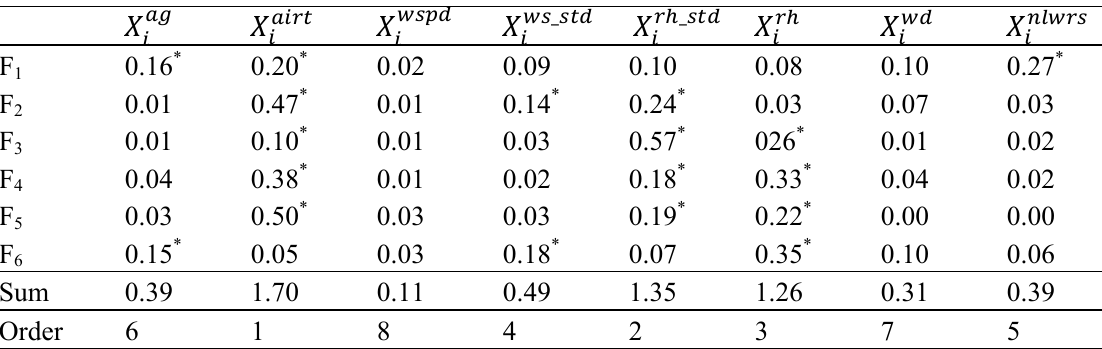
Table 4. BPN weight table of daily mean data.